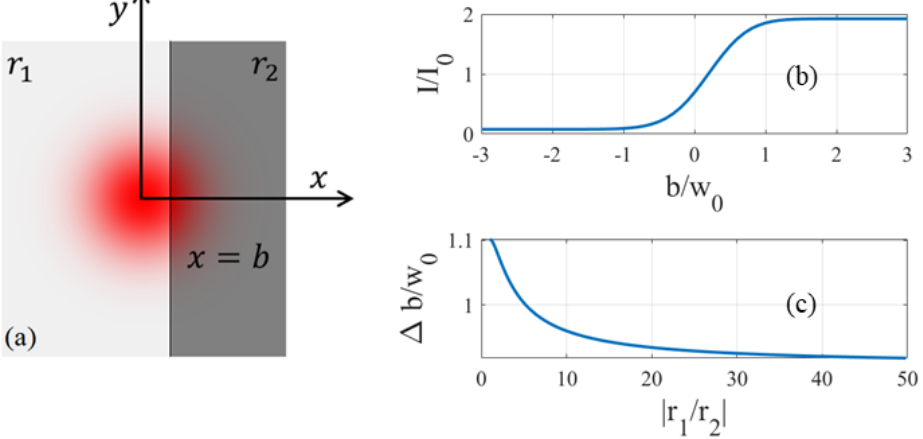
Figure 4. Change in reflected wave intensity across the boundary between two regions of different reflectivity. ( a ) The beam spot of the fiber output that falls on the boundary between two regions of different reflectivity on the surface of the sensor chip. ( b ) Intensity of the reflected wave as a function of b , the distance of the beam center from the boundary line, measured in units of the average intensity in the two regions, I 0 . The amplitude reflection coefficient r 1 = 5 r 2 , and w 0 is the field mode radius of the fiber. ( c ) The transition width in the reflected wave intensity as a function of | r 1 / r 2 |